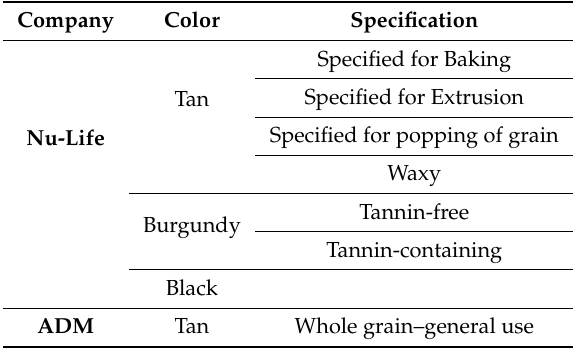
Table 1. Commercial available sorghum